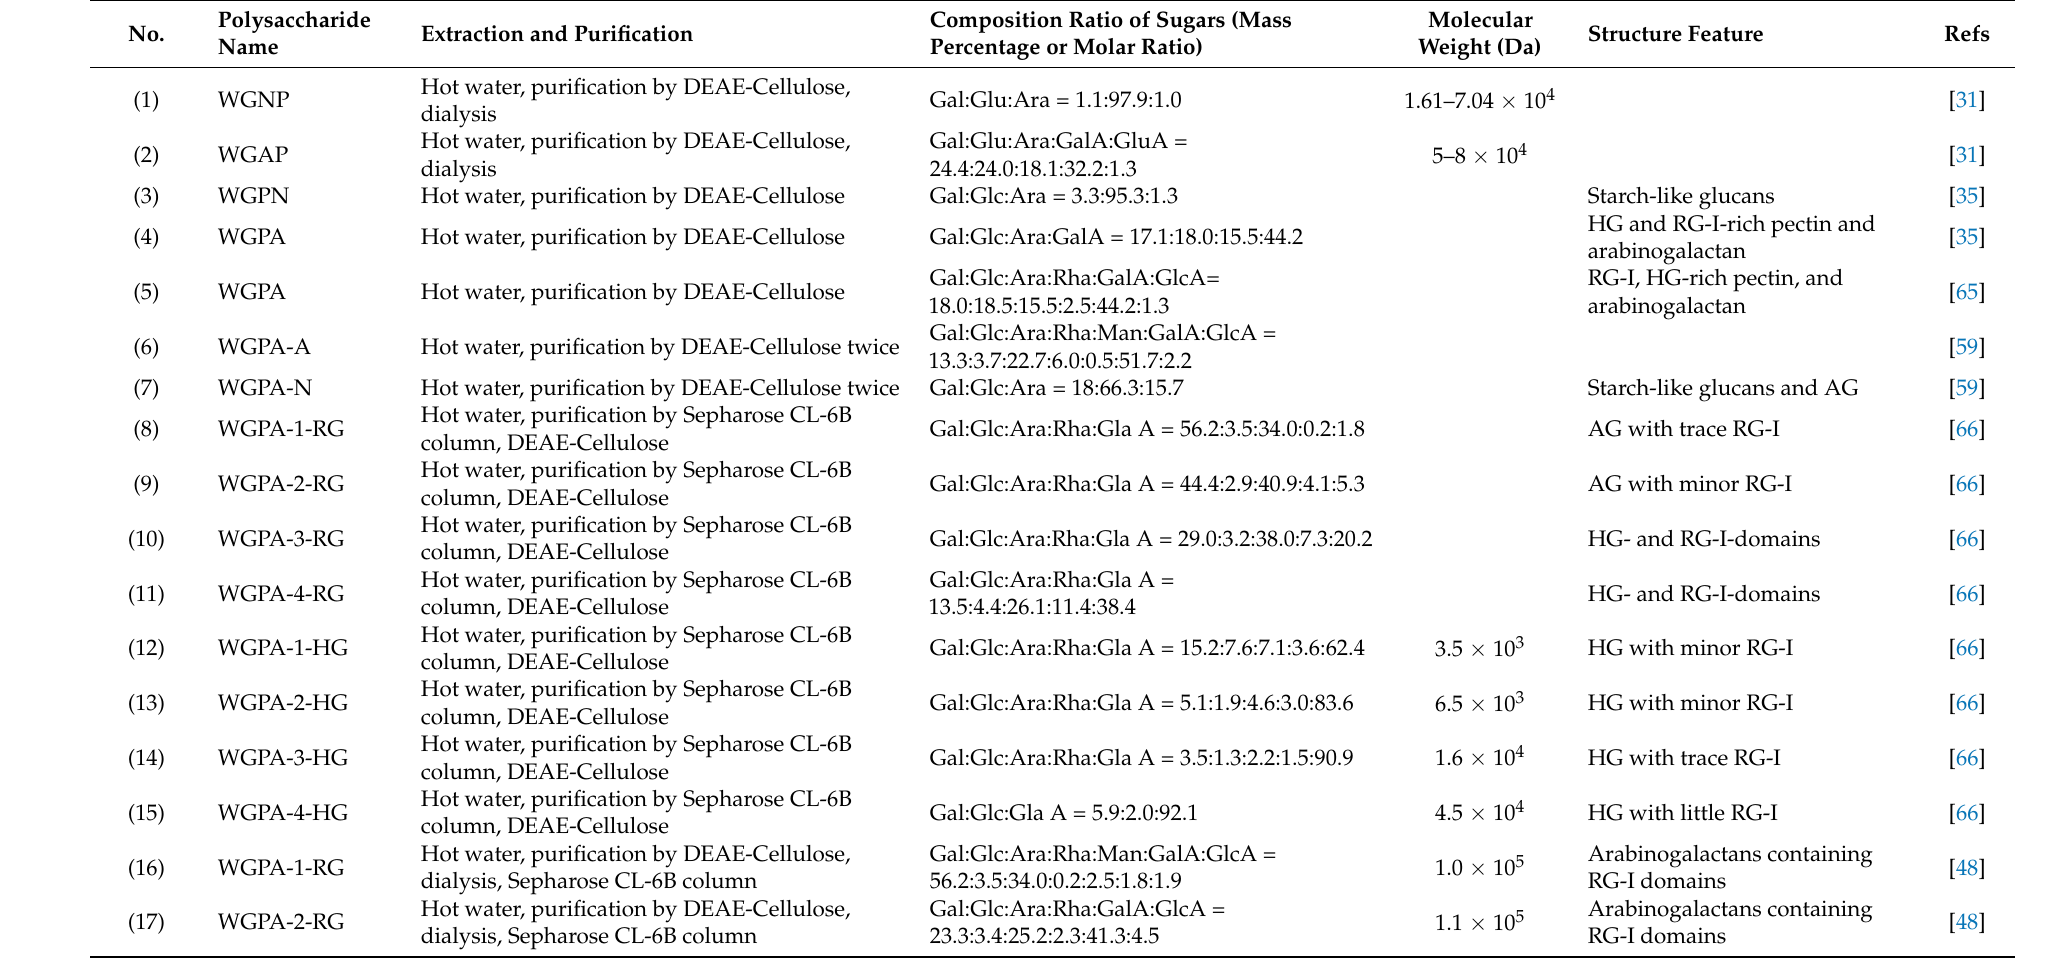
Table 1. Structure and composition of ginseng